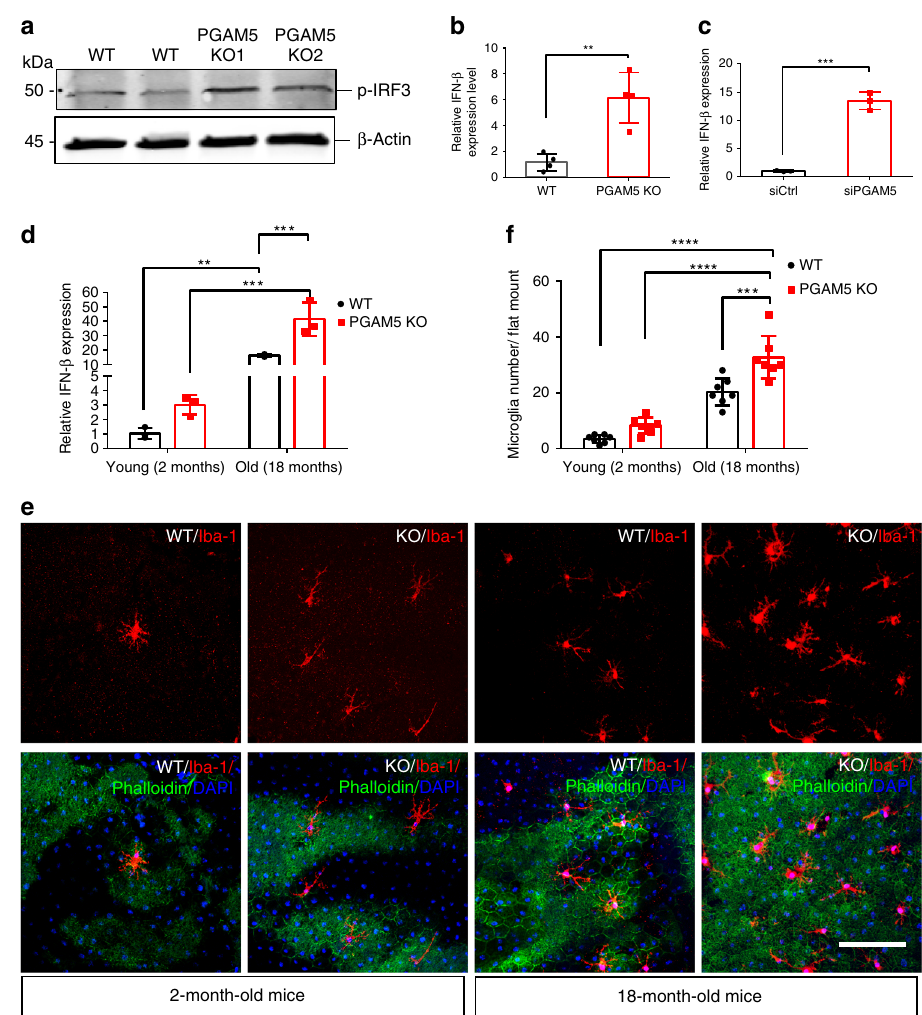
Fig. 9 PGAM5 deletion promotes the IRF/IFN- β pathway. a Upregulation of phosphor-IRF-3 protein by western blot in PGAM5 − / − ARPE-19 cells compared to control cells. β -Actin was used as loading control. n = 3. b Upregulation of IFN- β by qRT-PCR in PGAM5 − / − ARPE-19 cells compared to control cells. Data were normalized to GAPDH. n = 4, *** p = 0.003, two-tailed unpaired t -tests, error bars, mean ± s.d. c Upregulation of IFN- β by qRT-PCR in ARPE-19 cells after PGAM5 silencing by siRNA compared to control cells. Data were normalized to GAPDH . n = 3, *** p = 0.003, two-tailed